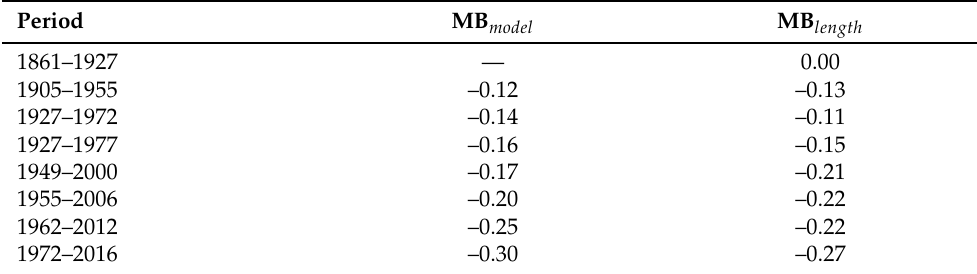
Table 3. Comparison of modeled mass balance (m w.e. yr − 1 ) and reconstructed mass balance based on length changes (m w.e. yr − 1